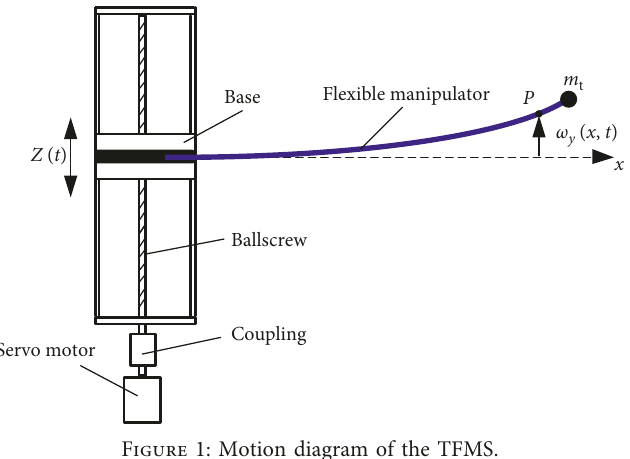
Figure 1: Motion diagram of the